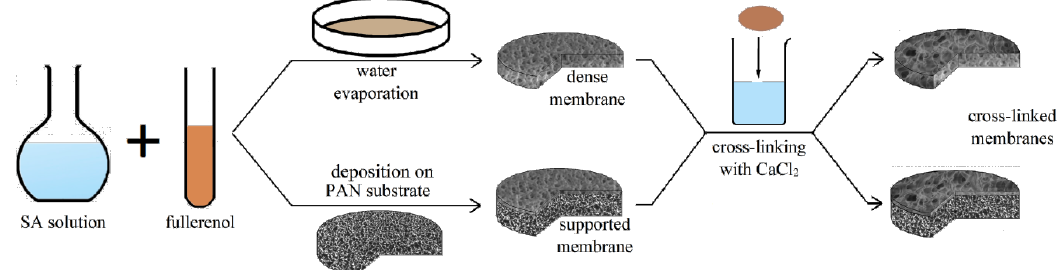
Figure 1. The scheme of preparation and cross-linking of dense and supported membranes based on sodium alginate (SA) and its composite SA–fullerenol.